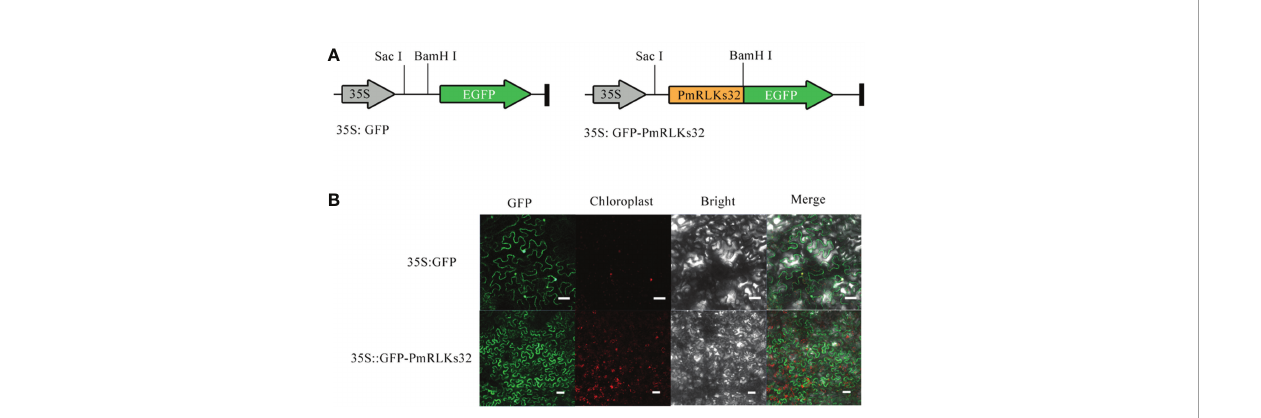
FIGURE 4 Subcellular localization of PmRLKs32 in Nicotiana benthamiana leaf cells. (A) Schematic diagrams of the 35S:GFP vector and 35S:GFP- PmRLKs32 construct. (B) Fluorescence from 5S:GFP and 35S:GFP- PmRLKs32 transiently expressed in 4-week-old N. benthamiana leaves. The